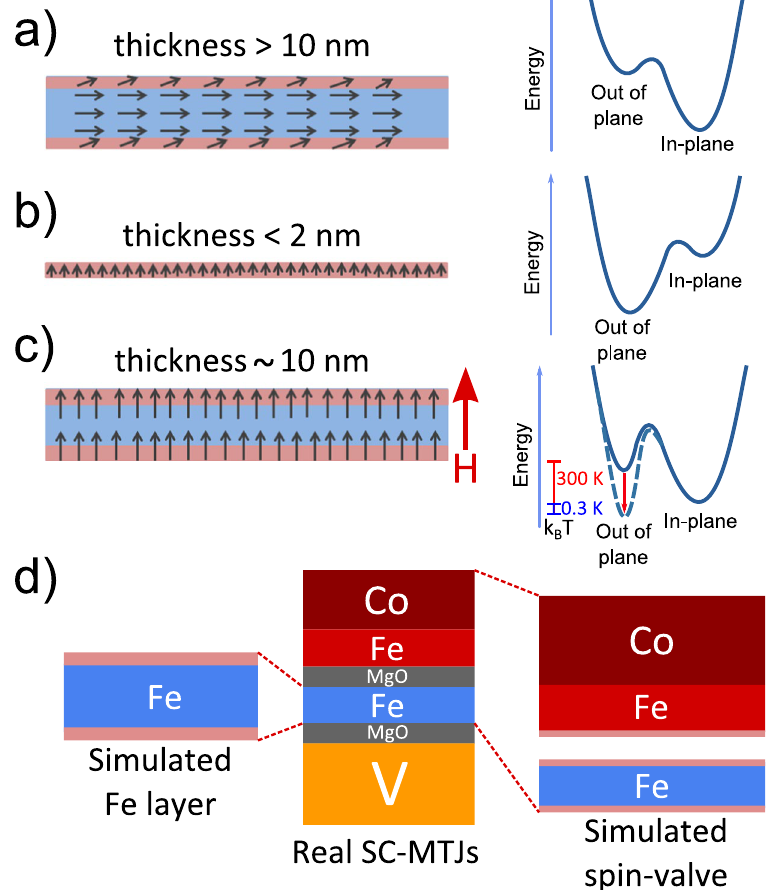
Figure 1. Sketch explaining the creation of non-volatile out of plane magnetization in thin ferromagnetic films showing the competing PMA and shape anisotropies. ( a ) For relatively thick films, due to shape anisotropy, the ground state is in-plane magnetized. ( b ) In thin enough films (typically < 2 nm), due to the dominant PMA, the ground state is magnetized out of plane already at room temperature. ( c ) Case of competing PMA and shape anisotropies taking place in finite lateral size and intermediate thick films (10 nm here). If an out of plane magnetic field is applied and removed at sufficiently low temperatures (indicated by vertical colour bars), the magnetization can switch from in-plane to the non-volatile out of plane state. The lower part ( d ) sketches the samples under study (middle) and the design of the simulated structures (left → soft MgO/Fe/MgO structure and right → soft layer weakly coupled to the hard layer, see text for